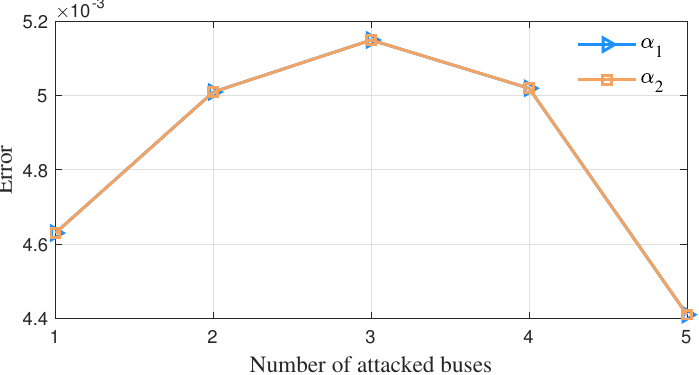
Figure 8. The error variation of the parameter α while the number of attacked buses varies.